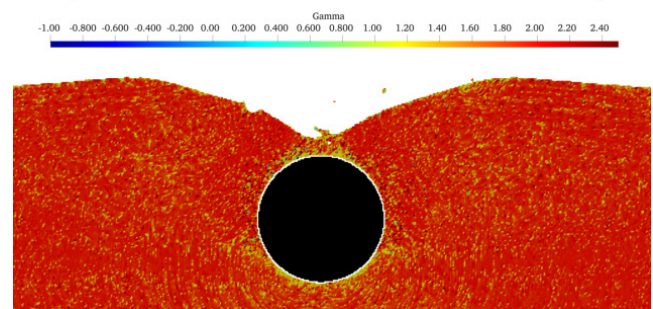
Figure 12. γ parameter when the obstacle is completely submerged at t (cid:63) = 2.4850 for Fr =